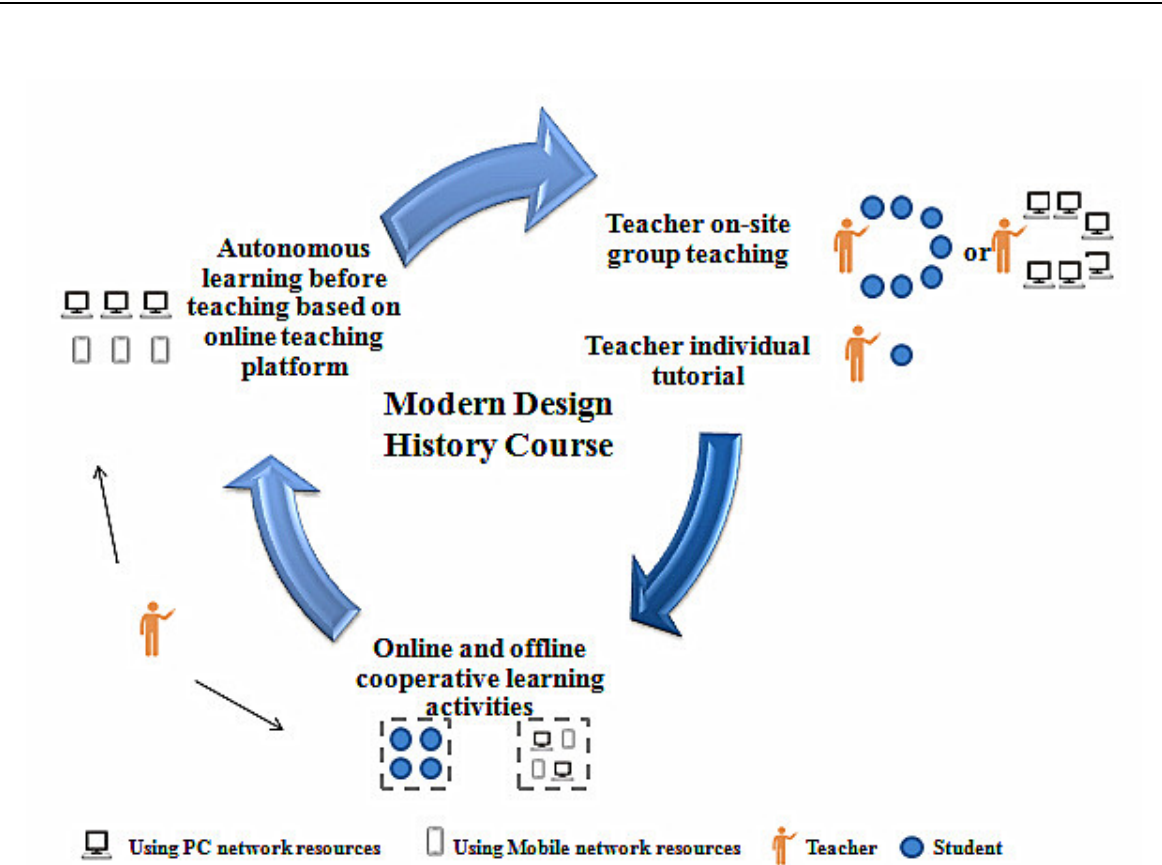
Figure 5. Schematic diagram of flipped classroom teaching in Modern Design